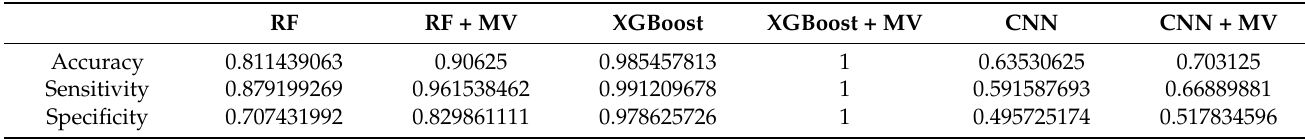
Table 2. Comparison of classification performance of RF, MLP, and CNN alone and using MV for tubers differentiation phenological stage using two